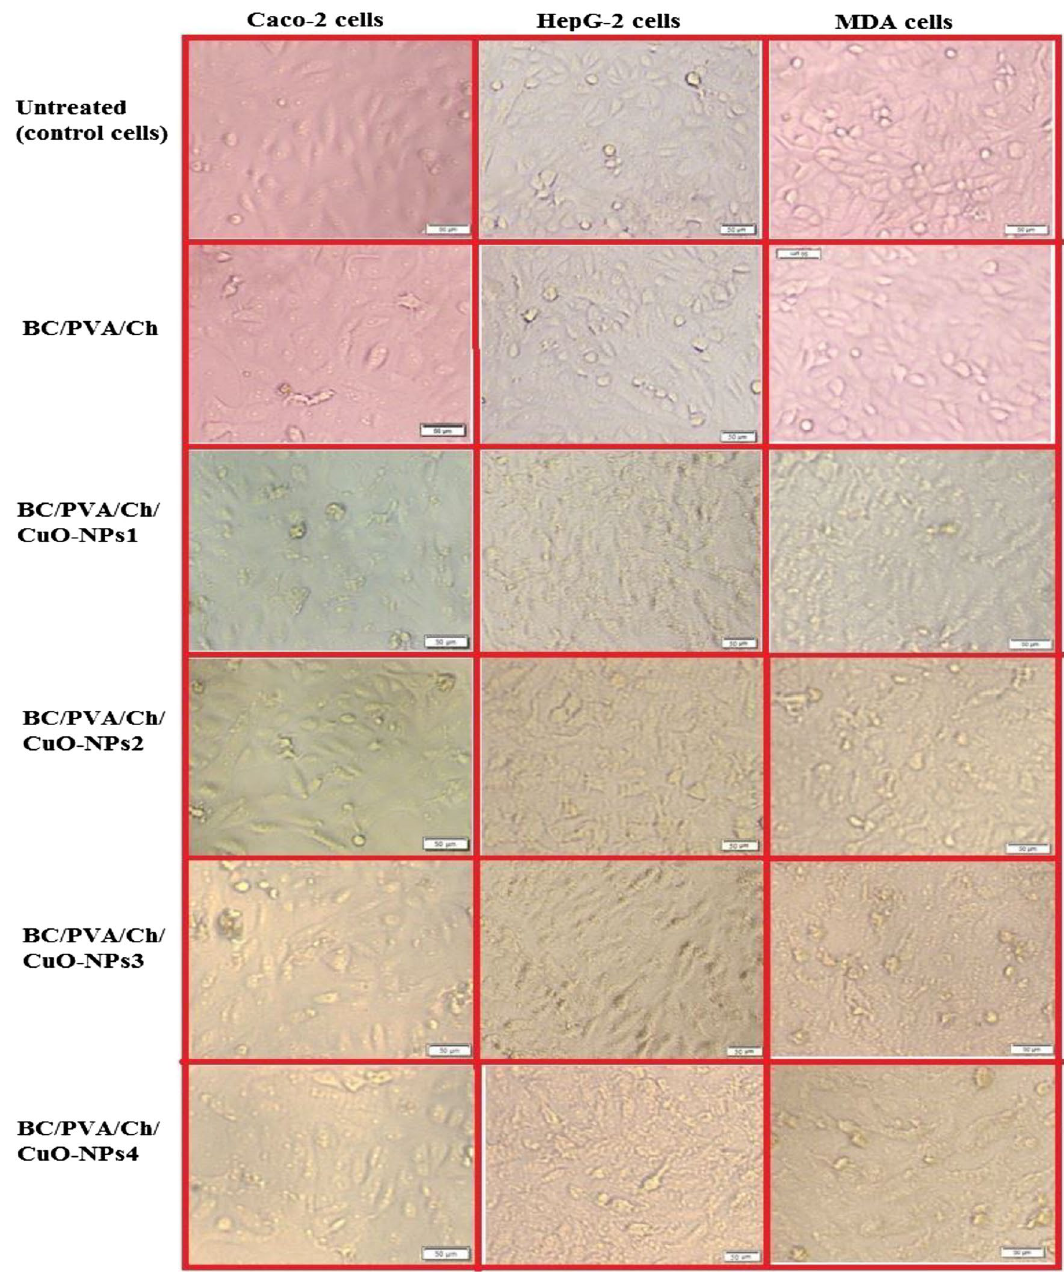
Figure 14. Effect of BC/PVA/Ch at four concentrations of CuO-NPs on the morphological changes of Caco-2, HepG-2, and MDA cancer cell lines as shown under an inverted phase-contrast microscope. Cells were treated at the IC 50 value of each prepared composite membrane and untreated (control) cells were included as negative worldwide, indicating major health challenges 124,125 . The results of larval mortality tests (Table 5) revealed that BC/PVA/Ch/CuO-NPs exhibited lethal effects against all stages of larval and pupal instar through their con- tact areas compared with control (ddH 2 O) that exhibited no mortality. The percentage mortality results of BC/ PVA/Ch/CuO-NPs against larval and pupal instar stages were positively dose-dependent, which increased with concentration. In research, the high mortality (%) recorded at BC/PVA/Ch/CuO-NPs4 (0.100 mg) during the immature stage of Aedes aegypti ( A. aegypti ) was 93.0, 81.0, 72.9, and 65.0% for I, II, III, and IV larval instars, respectively, whereas mortality percentage against pupal stage exhibits only 55.0%. The minimum concentration of BC/PVA/Ch/CuO-NPs1 (0.025 mg) recorded a mortality percentage of 12.9% for the immature pupal stage and 32.1, 28.4, 22.0, and 19.2% for I, II, III, and IV larval instars, respectively. The results are consistent with those of Salem et al., who found an increase in the larvicidal activity with the increase of Se-NPs concentra- tion and reported 100% larvae mortality at 100 ppm of Se-NPs as compared with other concentrations, which